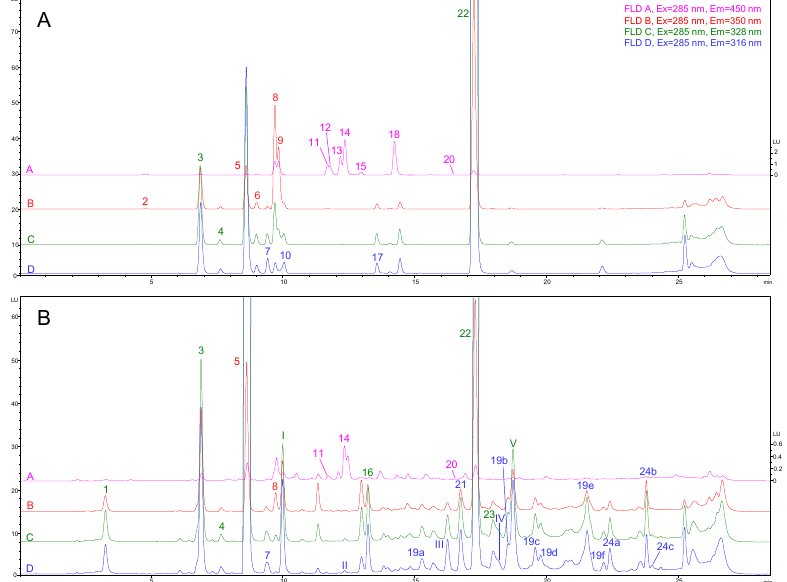
Figure 2. Chromatograms of: the standard mix with eighteen phenolic compounds at a concentration level of 10 µ g · mL − 1 ( A ); and a sample of olive oil from Picual variety ( B ). Peak identification numbers: (1) OxHTY; (2) Gal; (3) HTY; (4) DOPAC (IS); (5) TY; (6) 4-HBA; (7) 4-HPA; (8) Van; (9) Syr; (10) Hmvan;